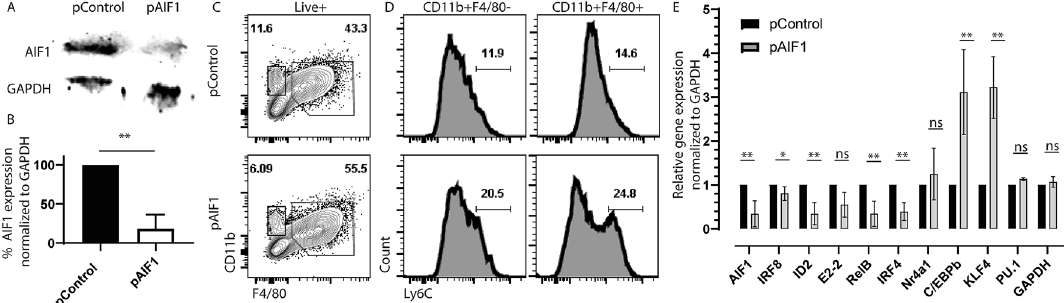
Figure 4. AIF1 silencing in bone marrow cells restrains macrophage differentiation. Bone marrow was collected from wild type mice prior to immediate transfection with Crispr-Cas9 plasmid carrying gRNA targeting AIF1 gene (pAIF1). Scramble gRNA served as control (pControl). Transfected bone marrow cells were stimulated for 6 days with M-CSF. ( A ) Western blot analysis was performed on pControl versus pAIF1 transfected bone marrow-derived macrophages to evaluate silencing of AIF1 expression. GAPDH served as internal loading control. Full-length blots/gels are presented in Supplementary Fig. 2. ( B ) Bar graph denotes percentage knockdown calculated using fluorescence intensity scale (ImageStudio 5.0). ( C ) For analogous studies, AIF1-silenced and control day 6 bone marrow-derived macrophages were collected and stained for CD11b, F4/80, and Ly6C prior to flow cytometric analysis. ( D ) Presence of Ly6C + monocytes were analyzed in both CD11b + F4/80 neg and CD11b + F4/80 + subsets. ( E ) Total RNA was isolated from AIF1-silenced or control bone marrow-derived macrophages differentiated under M-CSF stimulation for 6 days. Real-time PCR was performed to evaluate expression of: AIF1, IRF8, Id2, E2-2, RelB, IRF4, Nr4a1, C/EBPb, KL4 and PU.1. GAPDH t -test. * p < 0.05 and ** p <